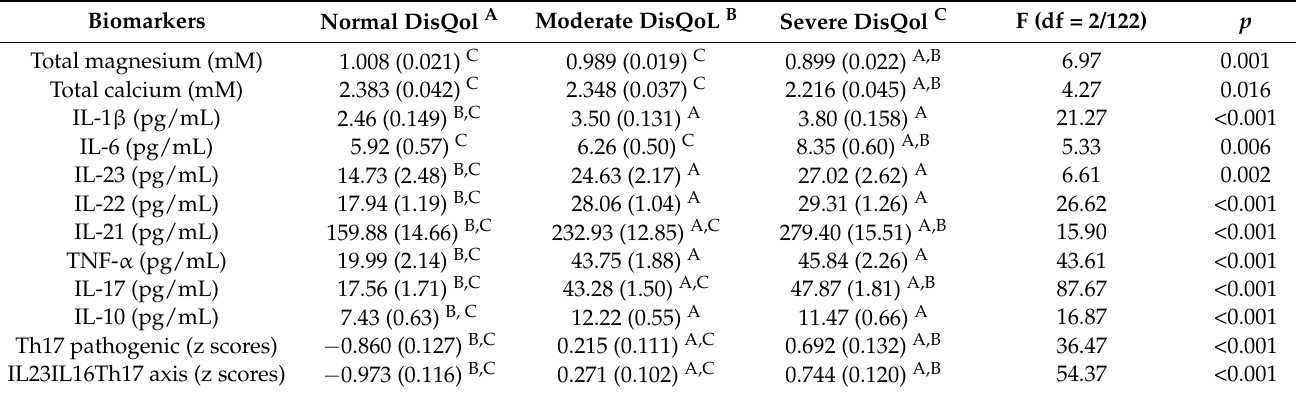
Table 3. Biomarker data in healthy controls and schizophrenia patients divided into subjects with severe disabilities and low quality of life (severe DisQoL), moderate changes in disabilities and DisQoL (moderate DisQoL) and those with normal DisQoL values (normal